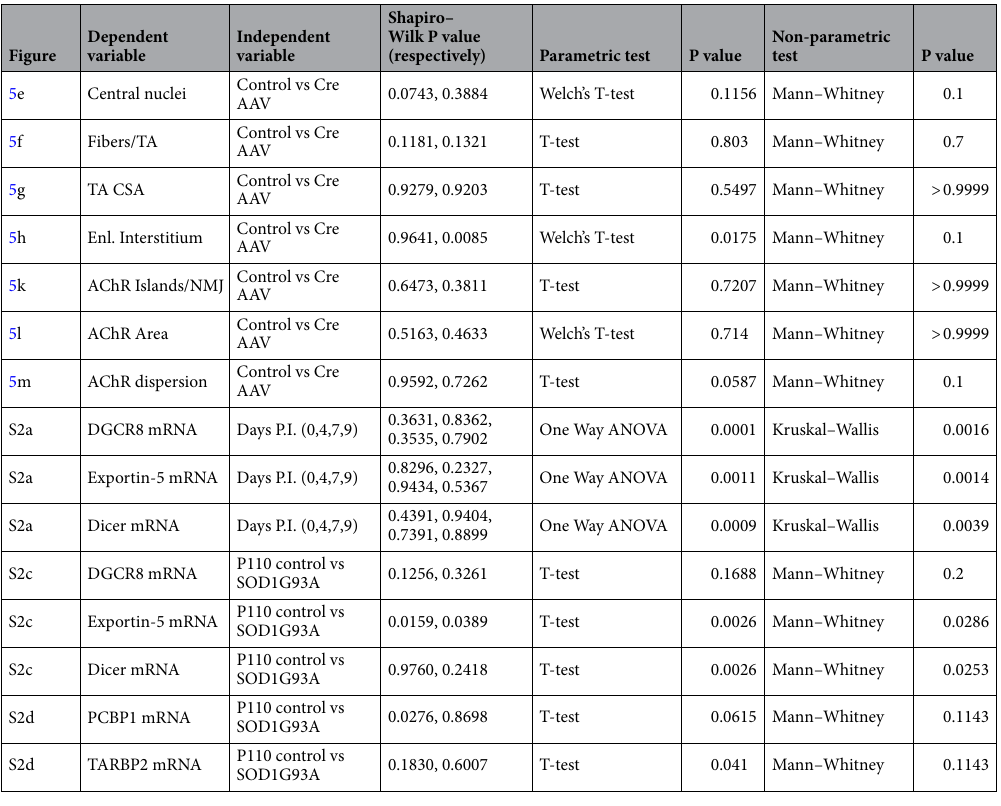
Table 2. Summary of